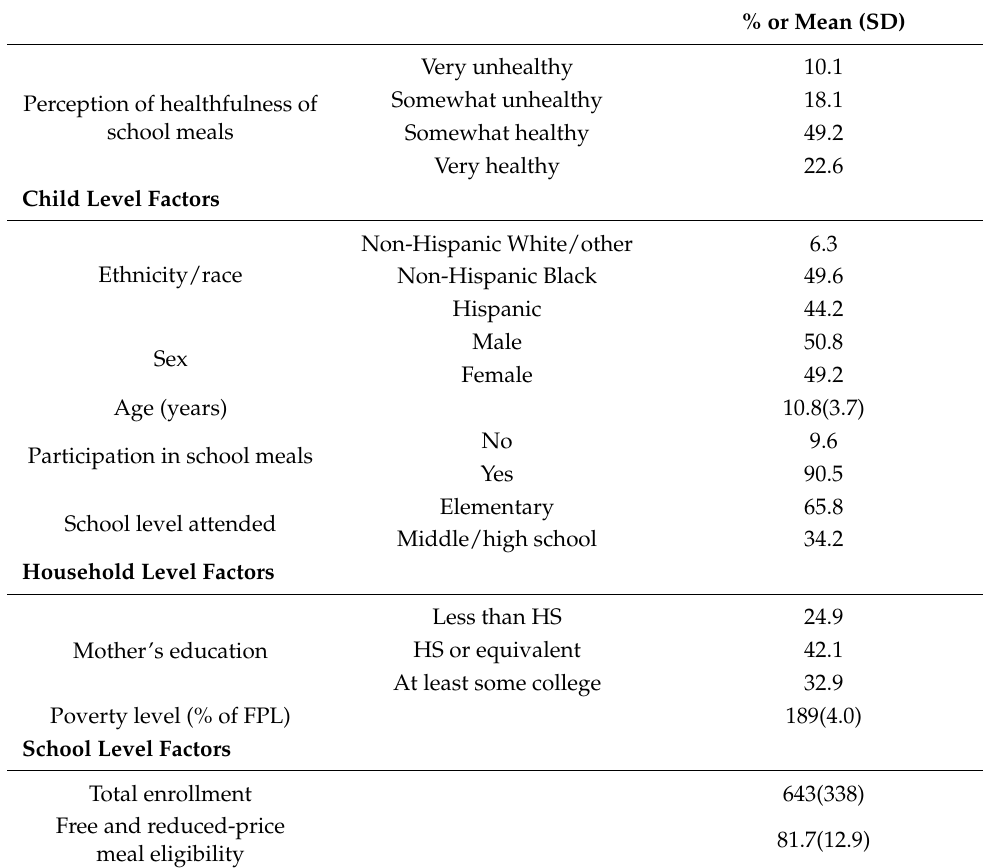
Table 2. Descriptive characteristics of the analytical sample (N =